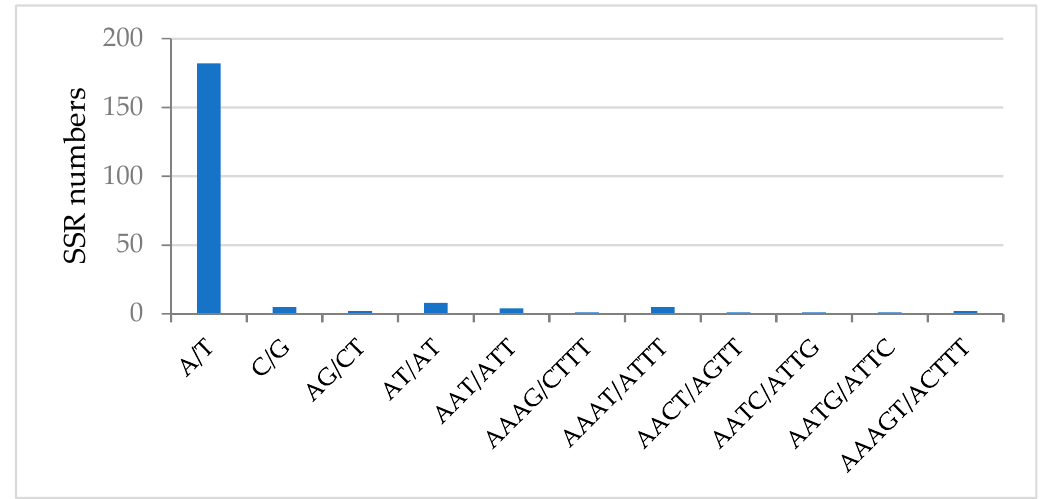
Figure 4. Frequency of different simple sequence repeat (SSR) motifs in different repeat types in the A. fruticosum chloroplast genome.